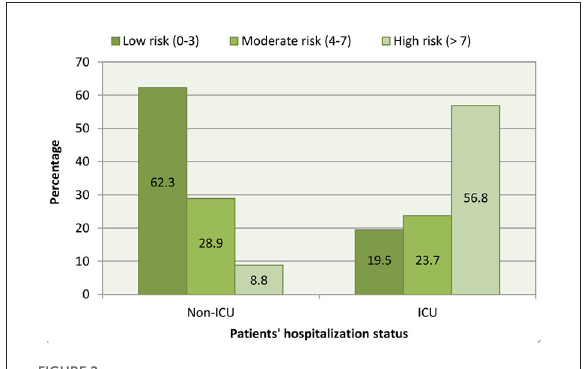
FIGURE2 Severity score in hospitalized patients due to